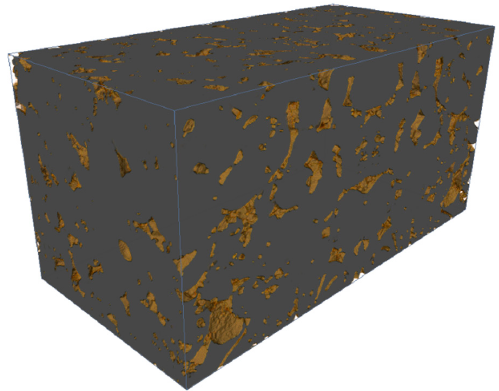
Figure 5. A sample of Portland carbonate of porosity 9.0%.